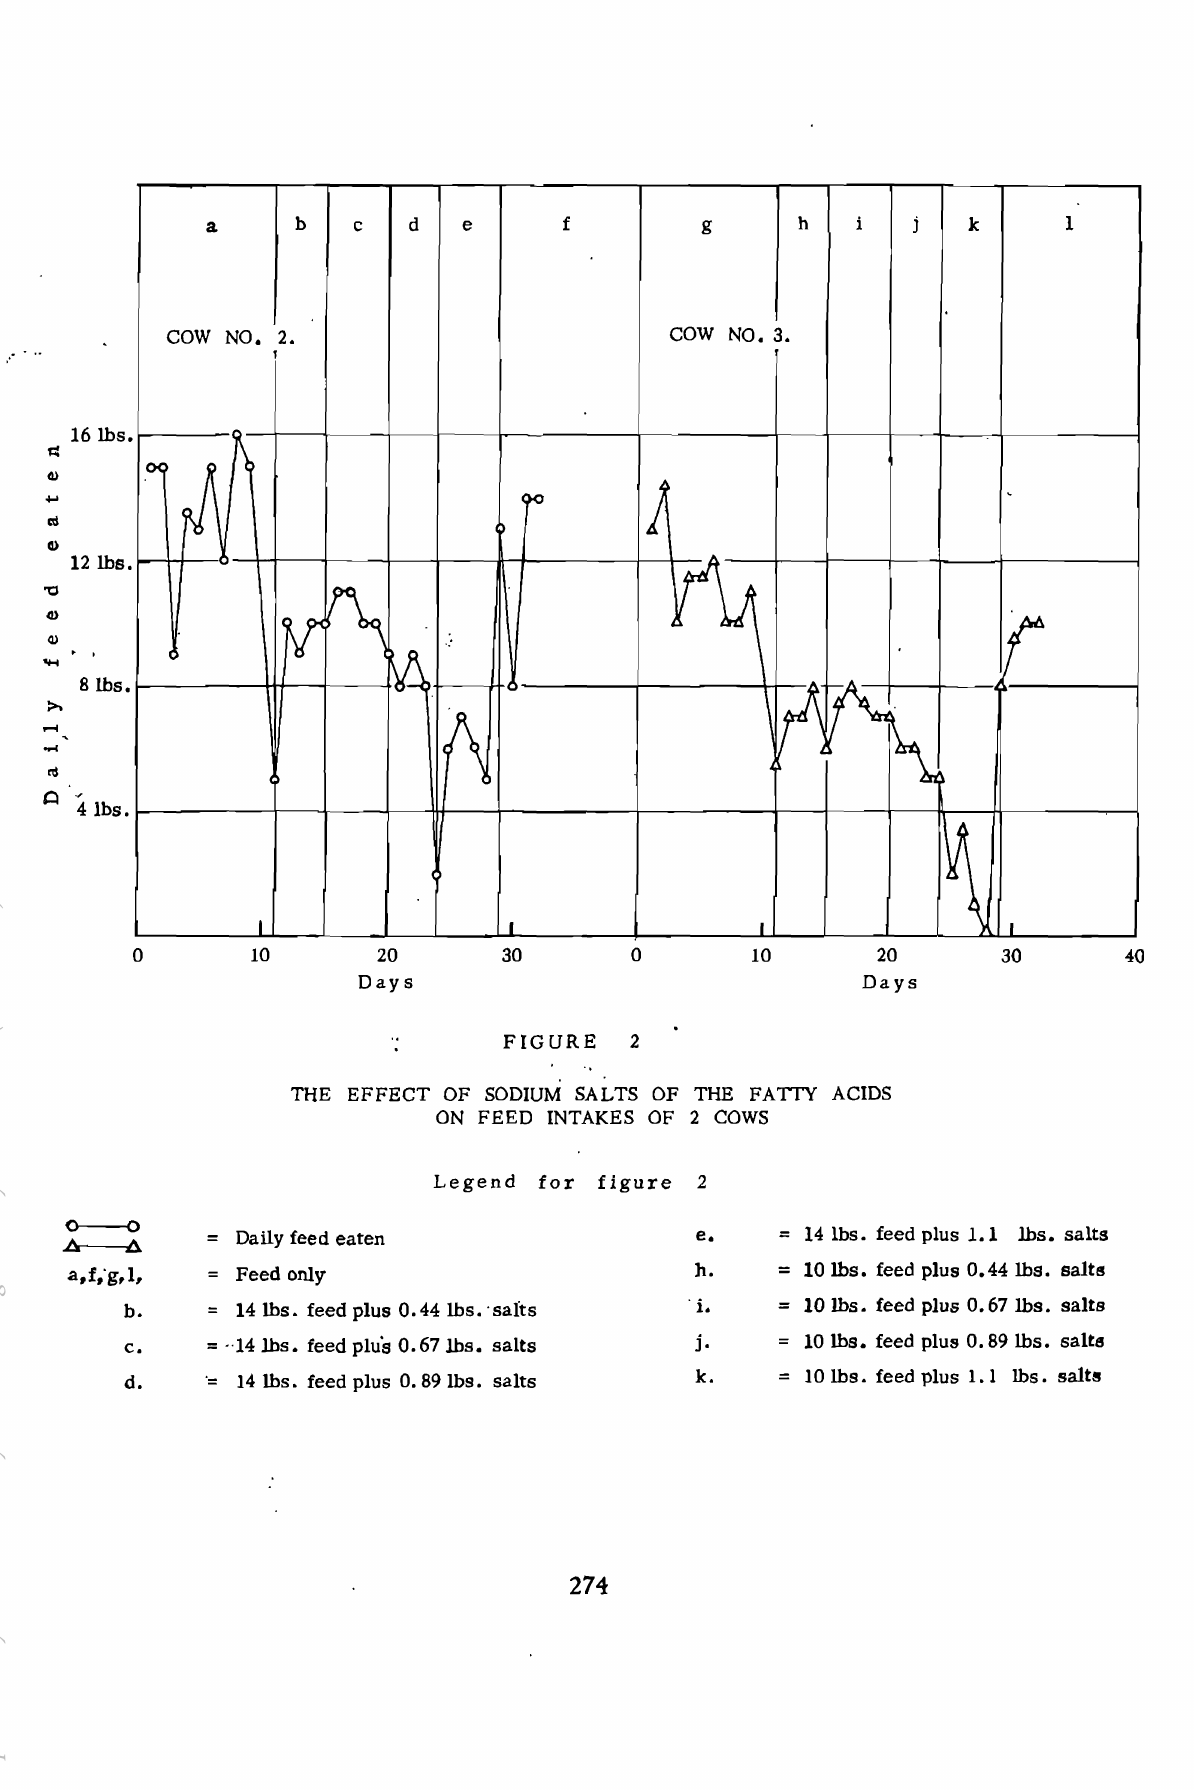
FIGURE 2 THE EFFECT OF SODIUM SALTS OF THE FATTY ACIDS ON FEED INTAKES OF 2 COWS Legend for figure 2 Daily feed eaten e. 14 lbs. feed plus 1. 1 lbs. salts Feed only h. 10 lbs. feed plus 0.44 lbs. salts 14lbs. feed plus 0.44lbs. 'salts . i. 10 lbs. feed plus 0.67lbs. salts = ··14lbs. feed plu's 0.67 lbs. salts j. 10 lbs. feed plus O. 89 lbs. salts - 14 lbs. feed plus 0.89 lbe. salts k. 10 lbe. feed plus 1. I lbs. salts